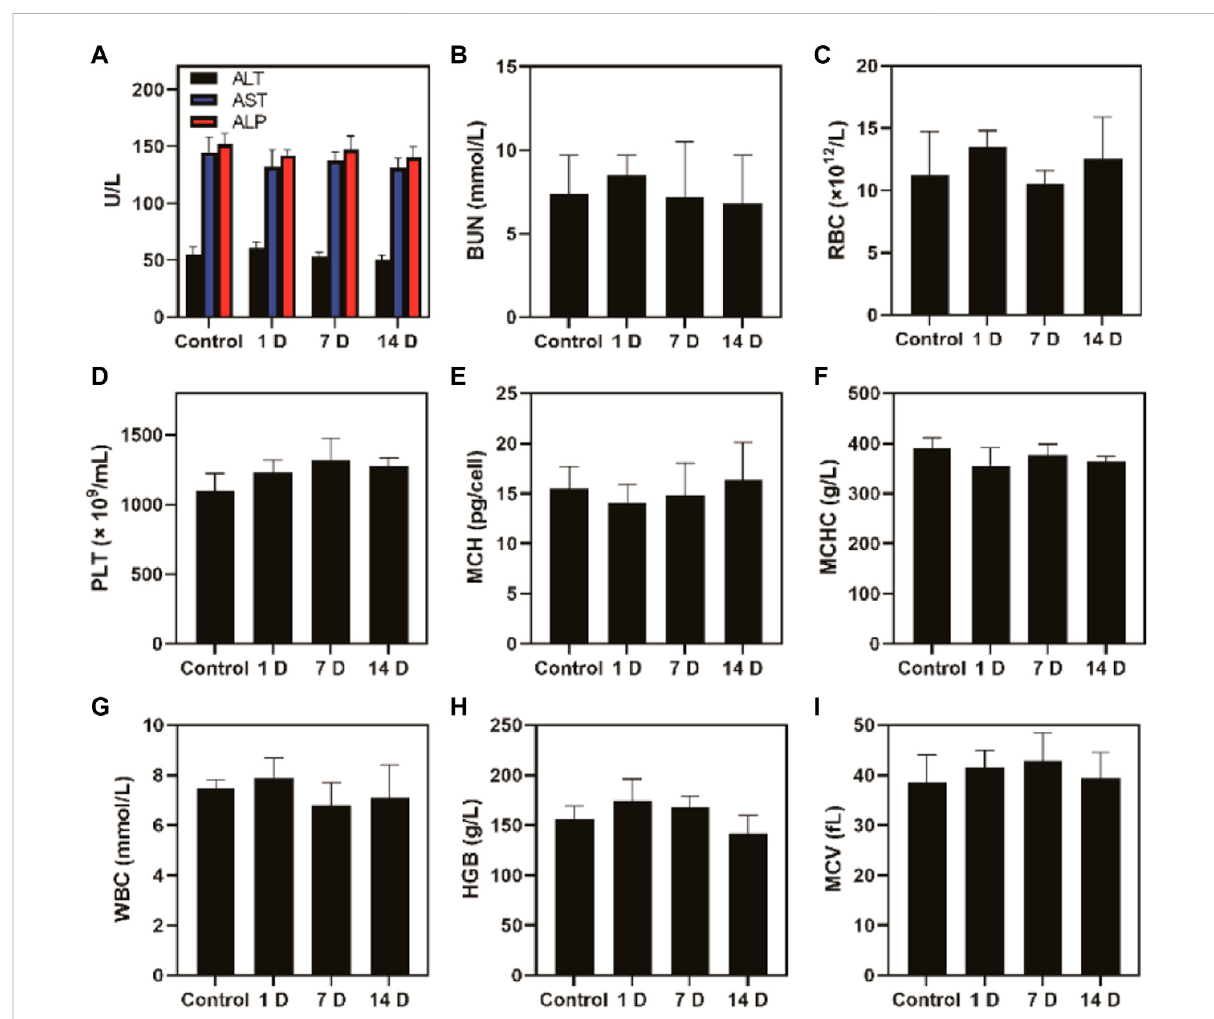
FIGURE 5 Blood biochemistry analysis ofhealthyBalb/cmice and mice administrated with FeGA-DOXon days 1,7and 14. (A) Aspartate aminotransferase (AST), alanine aminotransferase (ALT) and alkaline phosphatase (ALP). (B) Blood urea nitrogen (BUN); (C) red blood cell (RBC); (D) platelets (PLT); (E) haemoglobin (HGB); (F) mean corpuscular haemoglobin concentration (MCHC); (G) white blood cell (WBC); (H) mean corpuscular haemoglobin (MCH); (I) mean corpuscular volume